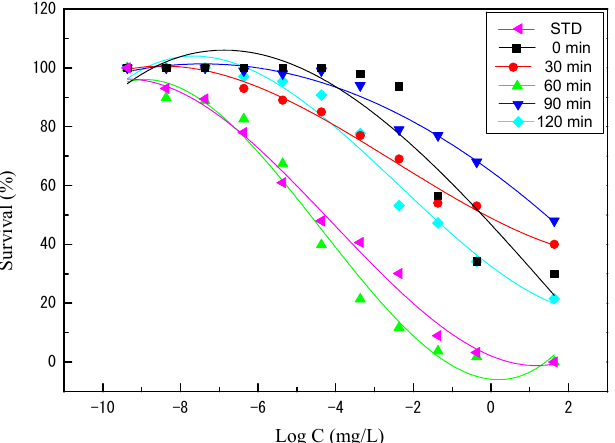
Figure 6. E. coli survival rate and LD 50 determination of pepsin digested 8 α -MSH with different cleavage times (0–120 min). Chemically synthesized α -MSH (STD) is included for comparison. Table 5. Lethality response for products from various cleavage intervals (unit: